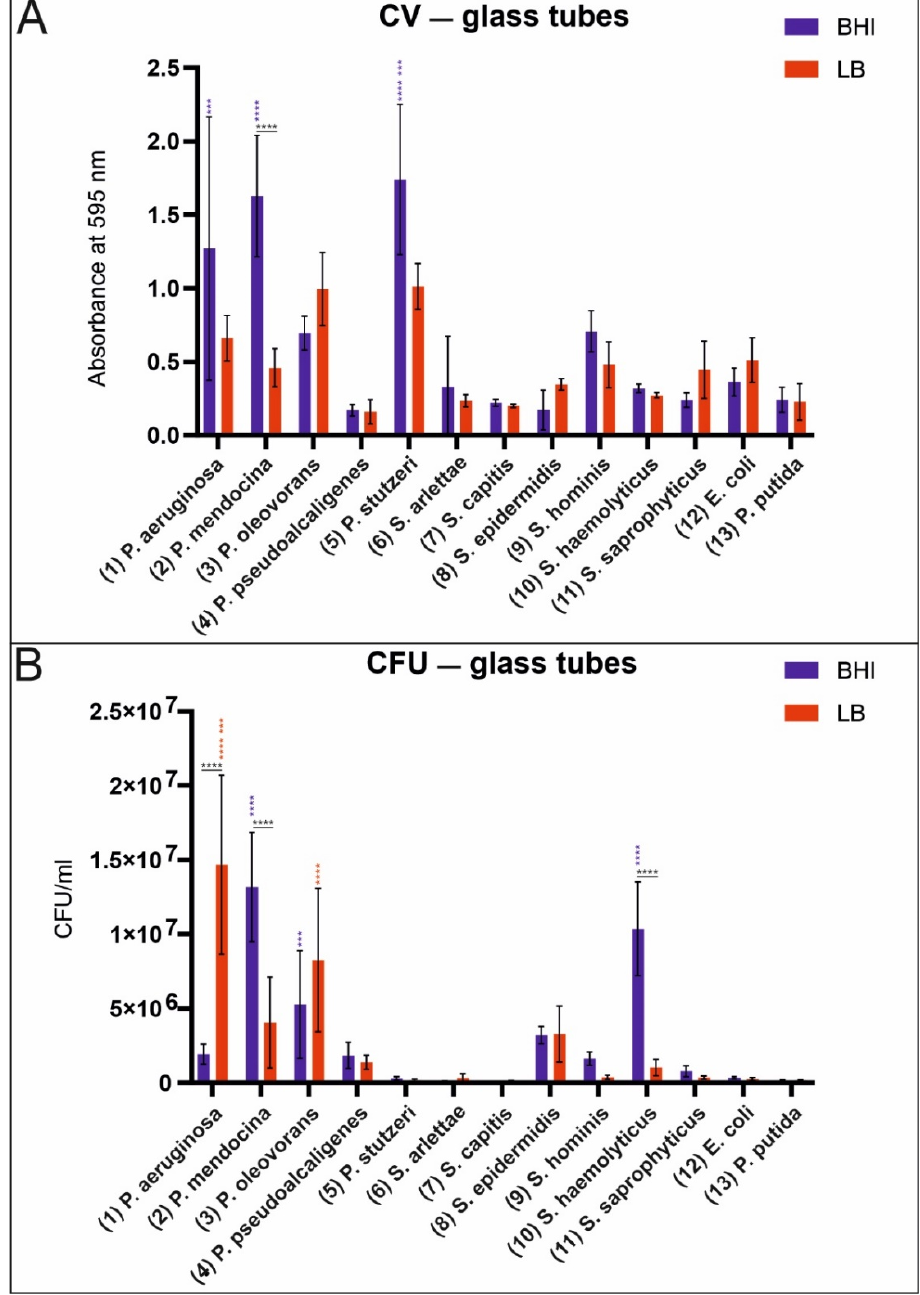
Figure 2. Bacterial attachment/biofilm production in laboratory glass tubes using BHI and LB growth media. Absorbance values of crystal violet staining of biofilms grown in BHI and LB media ( A ) compared to the colony-forming units (CFU/mL) ( B ). For statistical analysis, a two-way ANOVA or a mixed-effects analysis was performed. Only high-significance values are shown (0.0002 (***), <0.0001 (****)). Black stars in the horizontal direction show the significance values between the media used for cultivation for one bacterial strain. Blue and red stars in the vertical direction indicate the significance values for the BHI medium (blue) and the LB medium (red) based on one bacterial strain compared to all other bacterial strains. CV—glass tubes ( A ): The absorbance values of P. aeruginosa, P. mendocina , and P. stutzeri cultured in the BHI medium are significantly higher than those of all the other bacteria tested. CFU—glass tubes ( B ): The number of colony-forming units of P. mendocina and S. haemolyticus cultured in the BHI medium is significantly higher than that of all the other tested bacteria. P. oleovorans cultured in the BHI medium exhibited significantly more colony-forming units than S. capitis . The number of colony-forming units of P. aeruginosa and P. olevorans cultured in the LB medium is significant greater than that of all the other